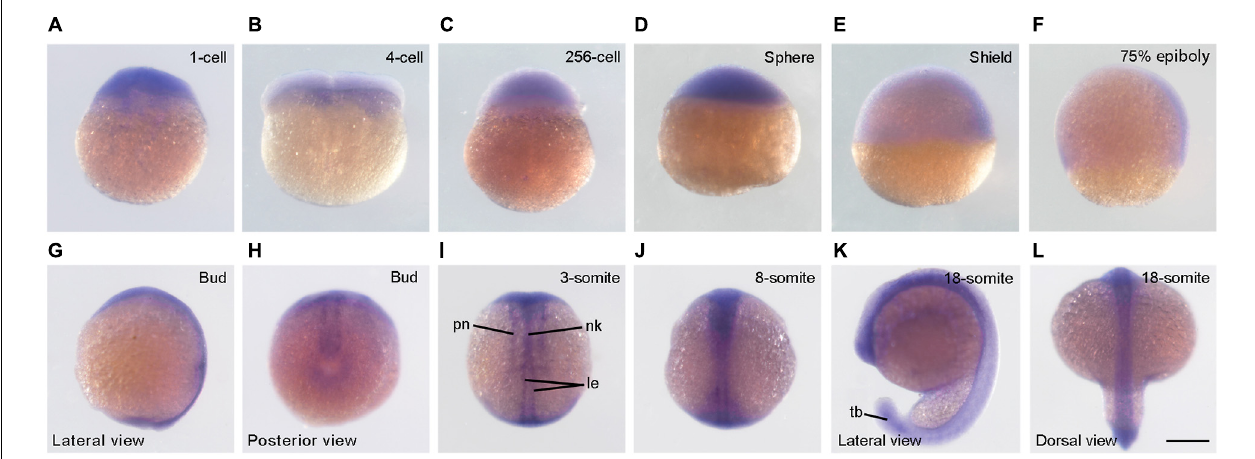
FIGURE 1 | Expression pattern of syne2b during early development. (A–D) At cleavage and blastula stages, syne2b transcripts are enriched in the blastodisc. Animal pole region is on the top. (E,F) Predominant expression of syne2b in the dorsal region during gastrulation. Lateral view with animal pole region on the top and dorsal region to the right. (G,H) Expression of syne2b along the anteroposterior axis at bud stage. (I,J) Dorsal views show syne2b expression in axial structures, including neural keel (nk), lateral edges (le) of neural keel and primary neurons (pn). (K,L) Expression of syne2b in the neural tissue and tail bud (tb). Scale bar: (A–L) 200 µ m.